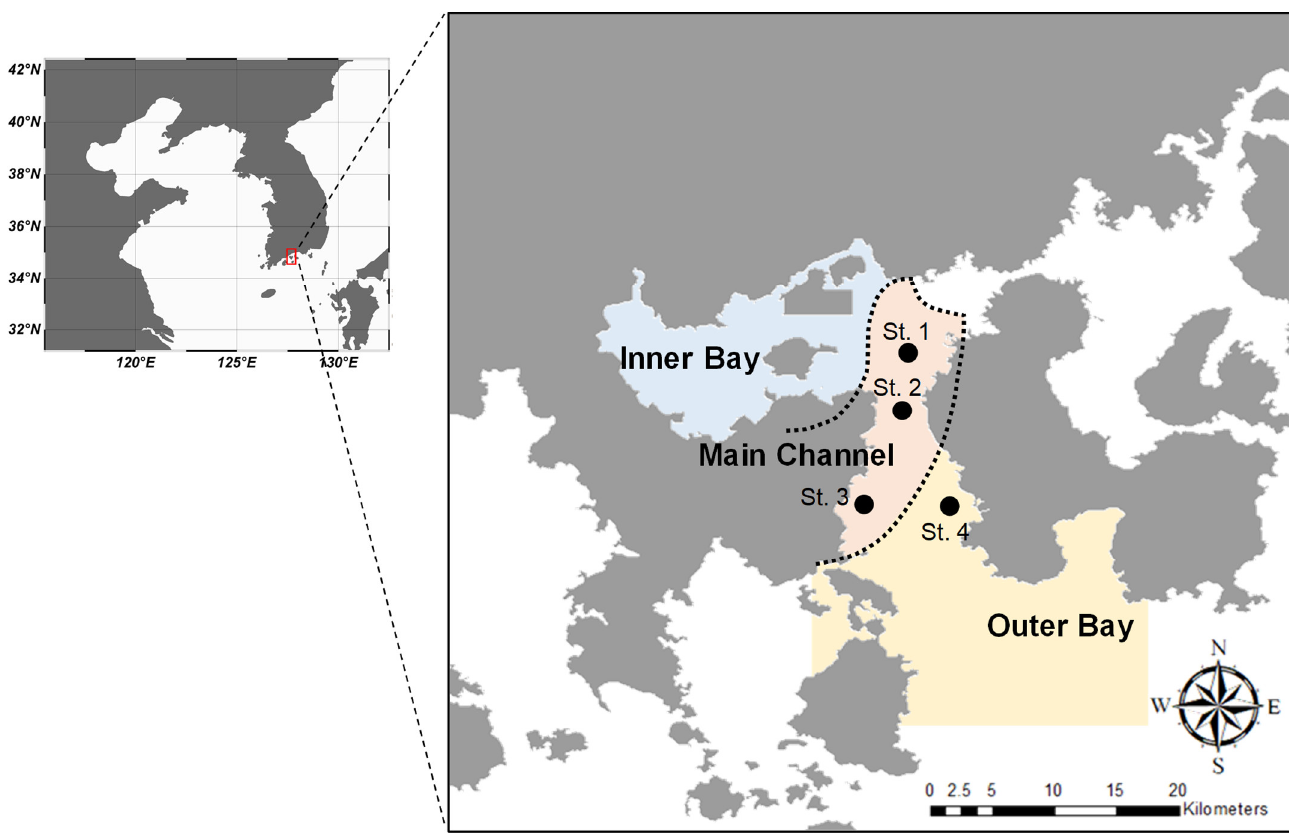
Figure 1. Map illustrating sampling sites in Gwangyang Bay. The boundaries in the bay are as defined by Kim et al. [23] 2019, based on physical and chemical properties.